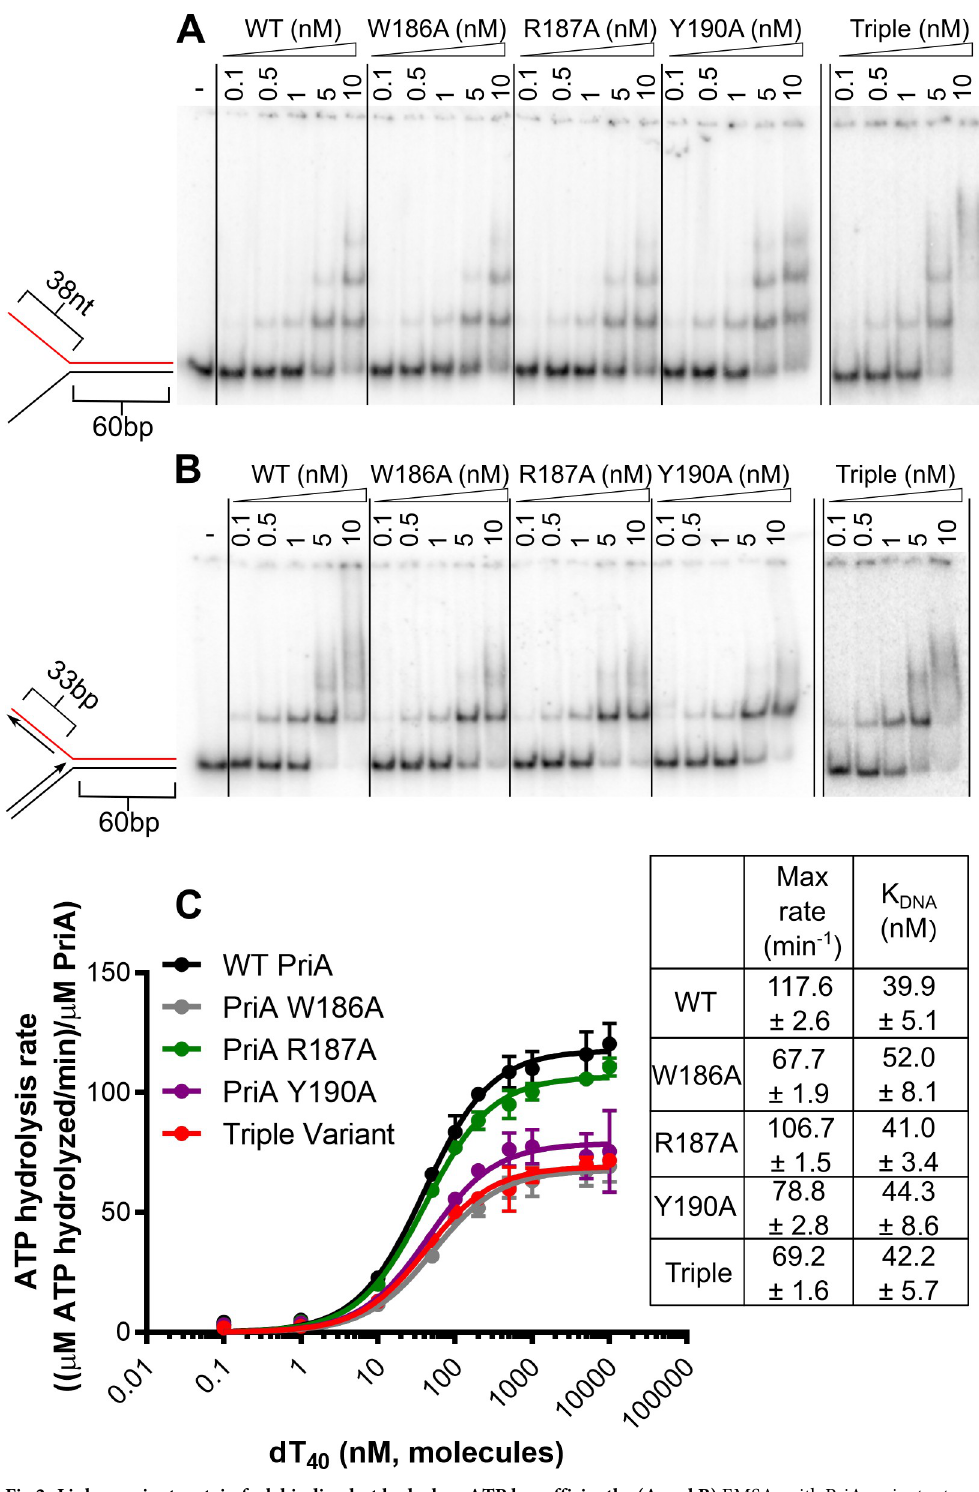
Fig 2. Linker variants retain fork binding but hydrolyze ATP less efficiently. (A and B) EMSAs with PriA variants at indicated concentration on a radiolabeled two-stranded fork (1 nM, molecules) (A) or four-stranded fork (1 nM, molecules) (B) . Substrates are depicted on left with radiolabeled strand shown in red. (C) ATP hydrolysis rate as a function of [dT 40 ] for each PriA variant (50 nM, molecules). Mean max rate and K DNA values derived from three replicates are listed, with error representing SD. Gels are representative of at least three replicates.